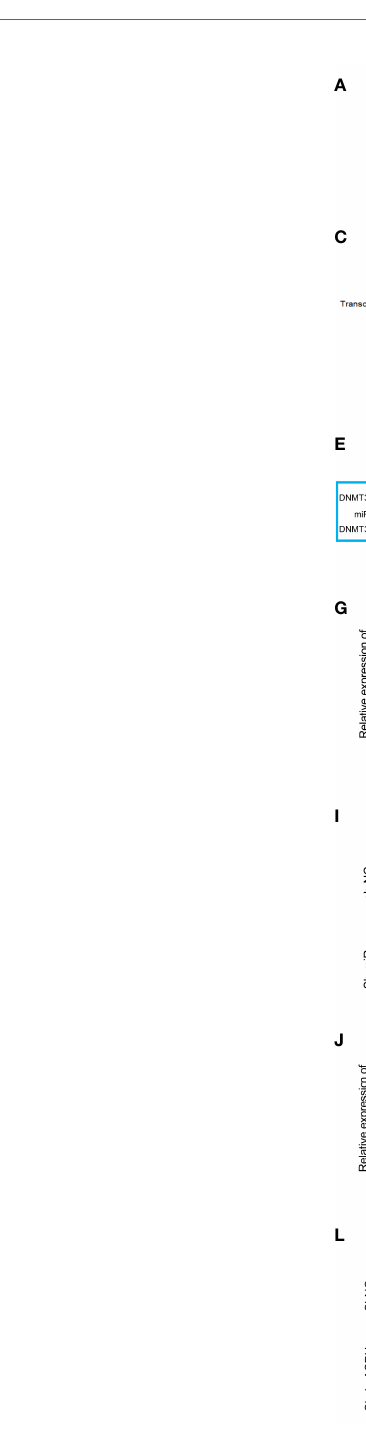
FIGURE 4 | CircASPH regulated the level of the DNMT3b/5mC Axis by sponging miR-370-3p in HCC cells. (A, B) Molecular function and biological process of miR-370-3p target genes in gene ontology analysis. (C) KEGG analysis of miR-370-3p target genes. (D) Heatmap of the expression of the DNMT gene family level in GSE124535. (E) Predicted binding sites between DNMT3b and miR-370-3p. (F) Dual-luciferase reporter assay showed that miR-370-3p could interact with the 3 ’ UTR of DNMT3b mRNA. (G, H) The expression of the DNMT3b level with miR-370-3p overexpression and knockdown was detected by RT-qPCR and Western blot. (I) Images of 5hmC-, 5mC-, and DAPI-stained HCC cells with different levels of miR-370-3p; scale bar = 20 m m. (J, K) The expression of DNMT3b level with circASPH overexpression and knockdown was detected by RT-qPCR and Western blot. (L) Images of 5hmC-, 5mC-, and DAPI-stained HCC cells with different levels of circASPH; scale bar = 20 m m. **p < 0.01, ***p <